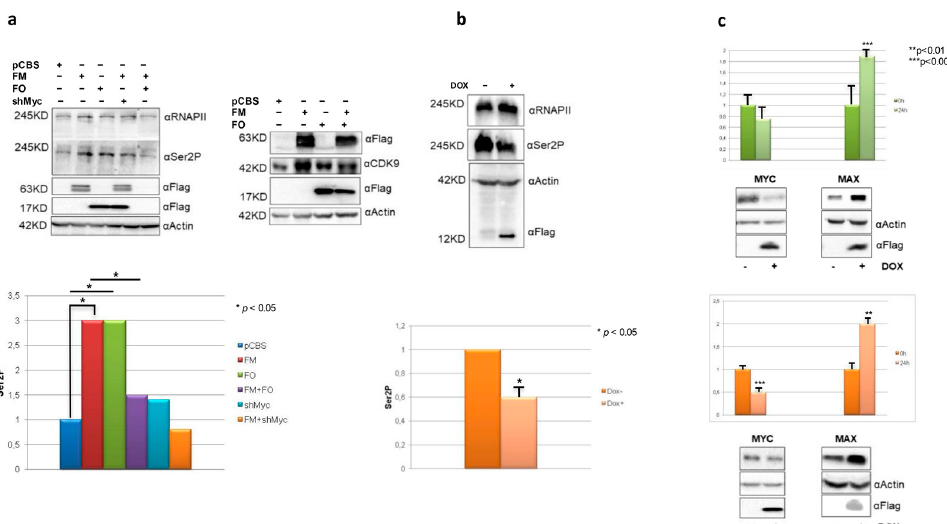
Figure 3. MYC inhibition impairs RNAPII Ser2 phosphorylation and increases Max protein. ( a ) Left: HEK293T cells transfected with pCBSFlagMYC, pCBSFlagOmomyc, and MYC shRNA plasmids— alone or in combination—and evaluated for RNAPIIser2 phosphorylation. Right: HEK293T cells transfected with pCBSFlagMYC, pCBSFlagOmomyc, and evaluated for CDK9 expression ( b ) BT168FO cells cultured in the presence or absence of doxycycline for 24 h, and probed with RNAPII Ser2P antibody. ( c ) BT168FO (top) and RamosFO cells (down) treated or not with doxycycline for 24 h, and probed with MAX and MYC